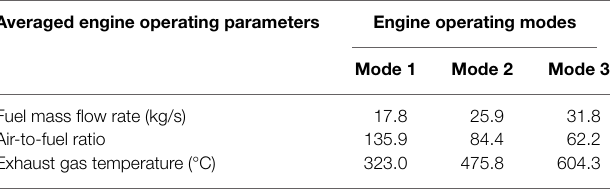
TABLE 1 | Averaged engine operating parameters for three operating modes on Jet-A1